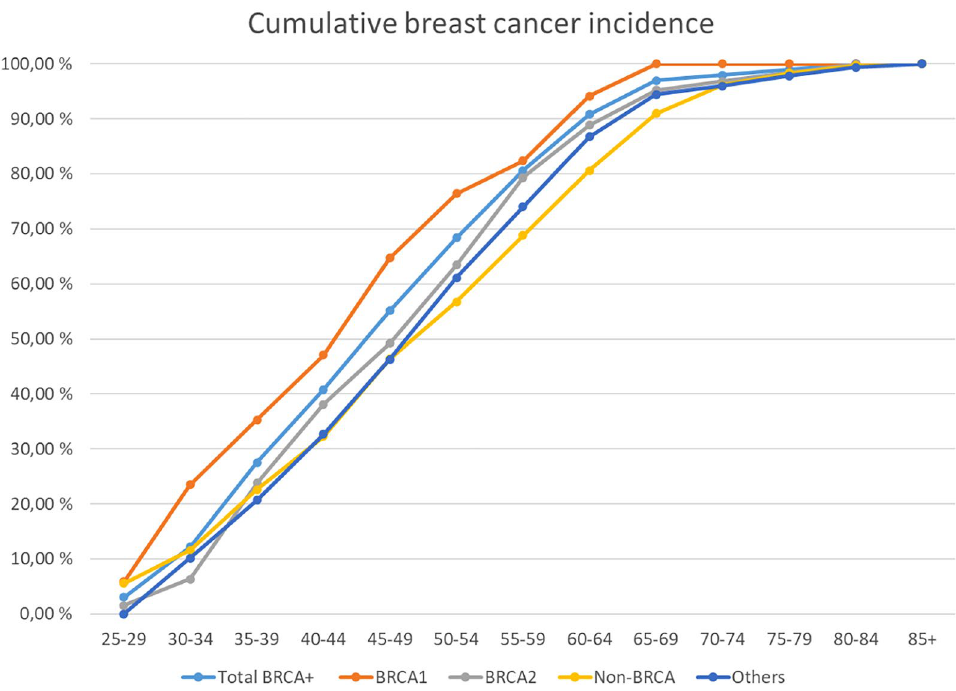
Figure 2. The onset age of breast cancer in BRCA -families, non- BRCA families with high risk and others. Exact values are marked with circles. Smoothing is used to make the curves more readable.